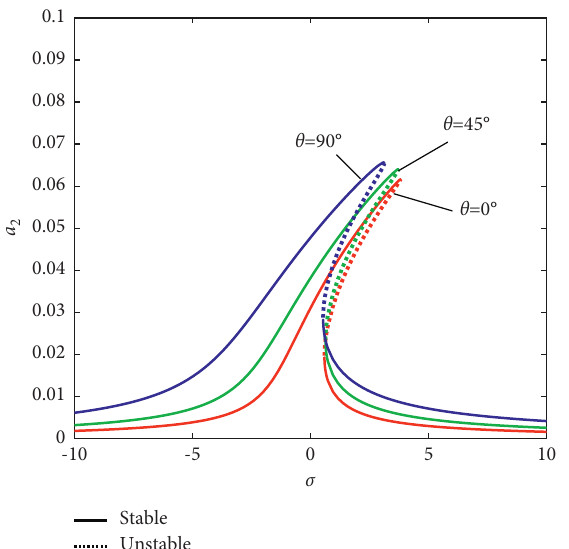
Figure 33: Frequency response curve with different ply configu- rations ( c � 0.05, L/d � 10, case II).